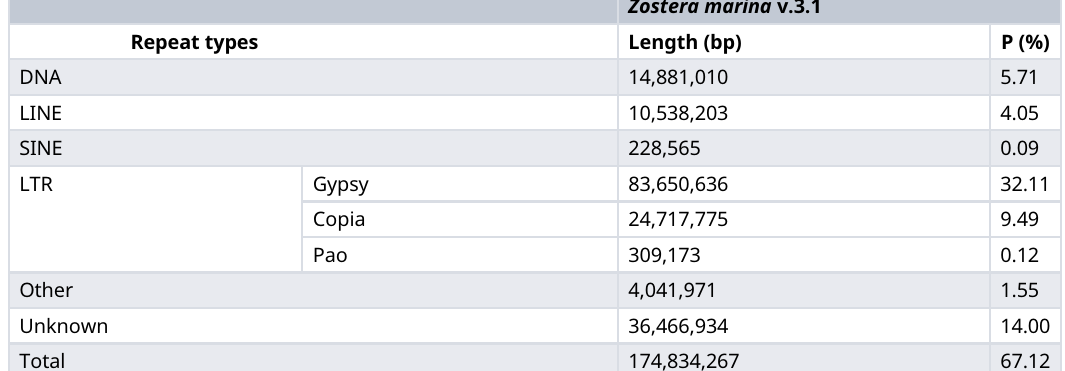
Table 2. Annotation of repeat